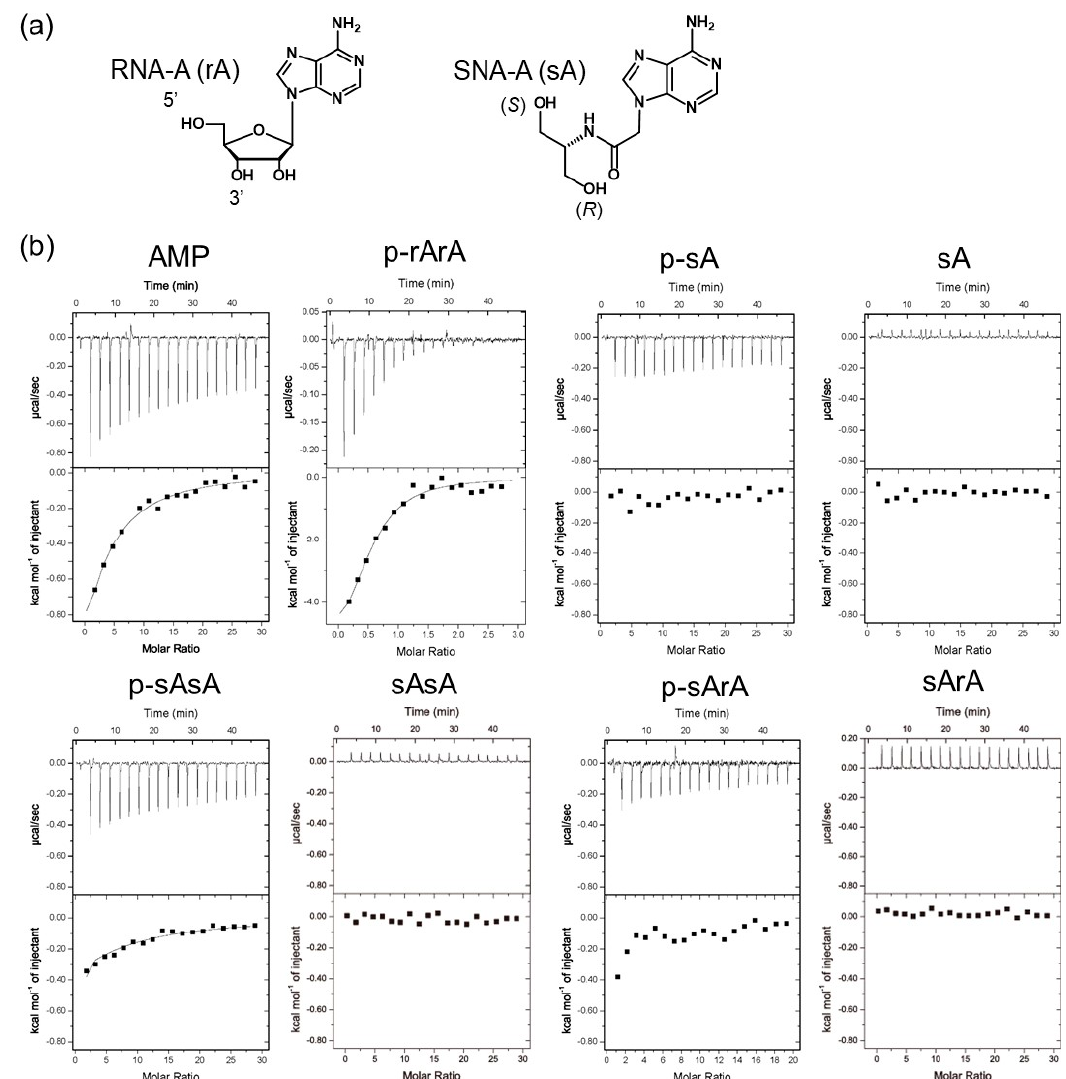
Figure 2. Isothermal calorimetry (ITC) analyses of the binding between AGO2-MID and mono- or dinucleotides. ( a ) Chemical structures of RNA and SNA mononucleotides. ( b ) ITC profiles of the binding between AGO2-MID and mono- and dinucleotides with or without terminal phosphate groups. ITC experiments were performed at 25 °C in 25 mM MES (pH 6.5), 200 mM NaCl, 1 mM tris(2-carboxyethyl)phosphine (TCEP). For each experiment, 20 µ M AGO2-MID was loaded into the sample cell. Table 1. K a values for the interaction of AGO2-MID with mono- and dinucleotides.